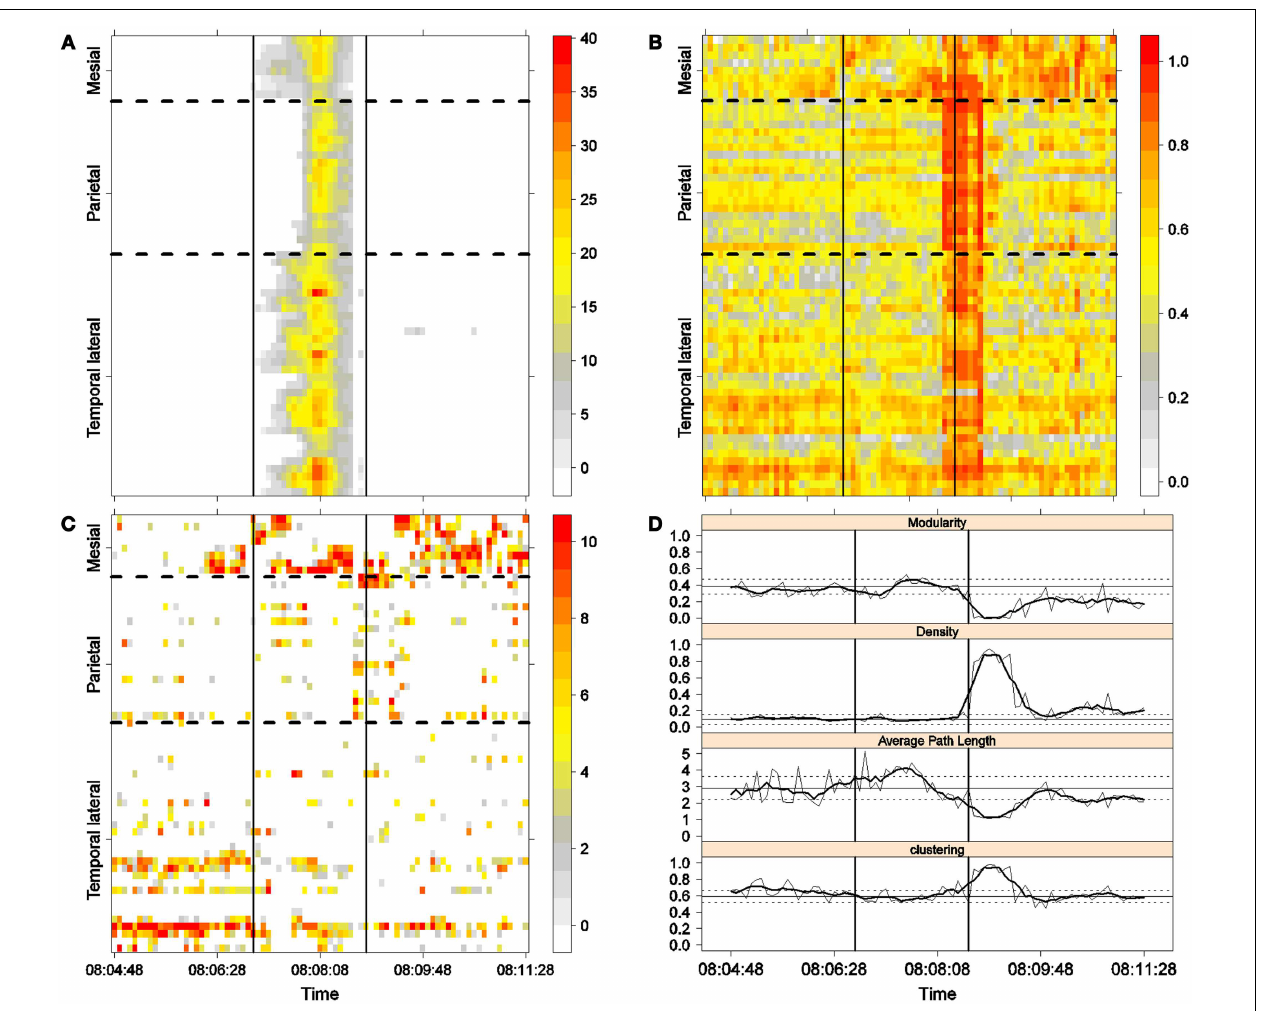
standard deviations of the corresponding measures during the interictal stage. The calculated values for each epoch are indicated by a thin, solid line, and the moving average of five consecutive epochs is shown with a thick, solid